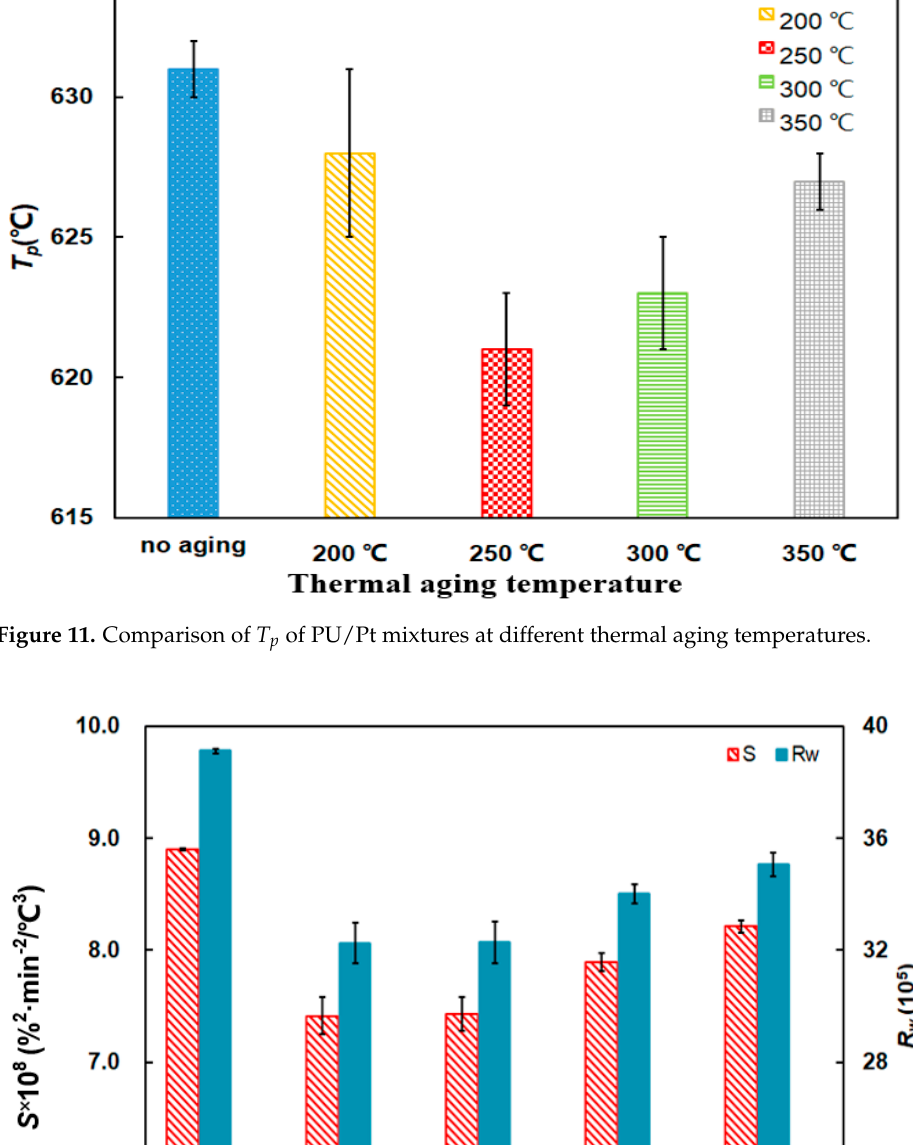
Figure 11. Comparison of T p of PU/Pt mixtures at different thermal aging temperatures.